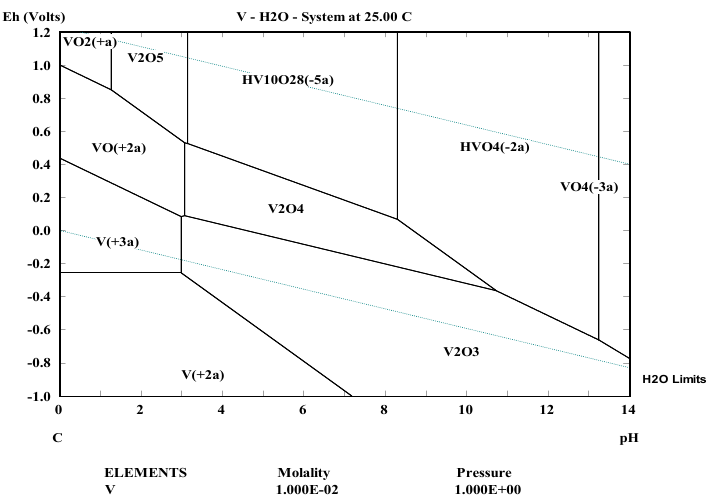
◦ C, 1 bar, and 10 − 2 M using HSC